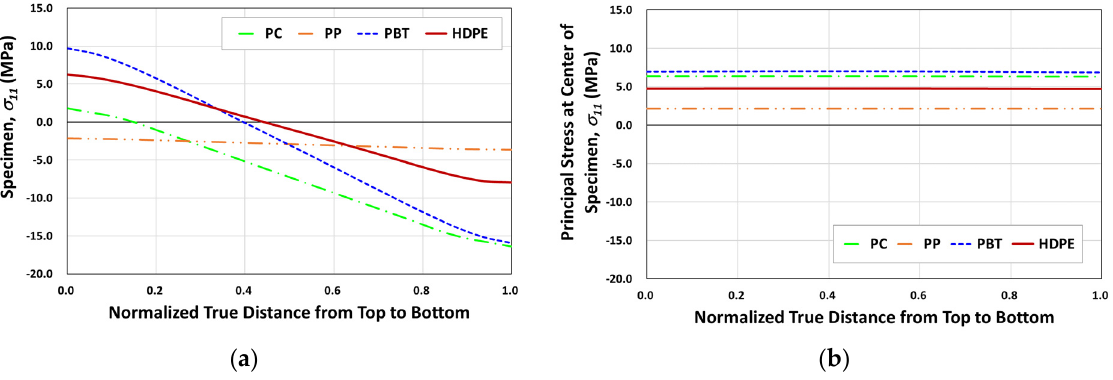
Figure 4. Through thickness variation of principal stress at the center point of the tensile specimen: